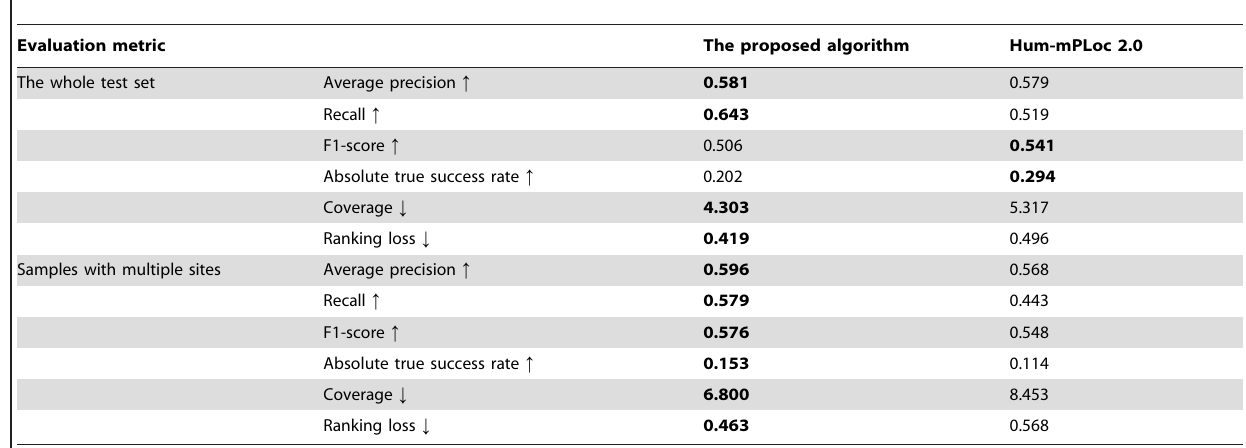
Table 2. The performance comparison between the proposed algorithm and Hum-mPLoc 2.0.